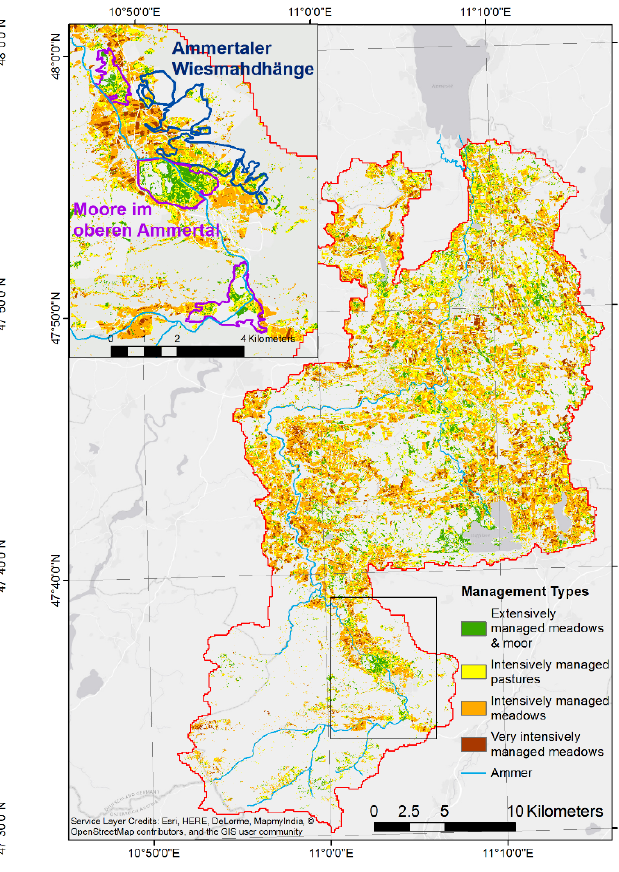
Figure 4: Map of the derived grassland management types including a zoom on the grassland sites in the Ammer valley with the Natura 2000 habitats hay meadows (orange outline) and moors (purple outline). Pixels for which the LAI time series was shorter than 7 points in time are left blank.